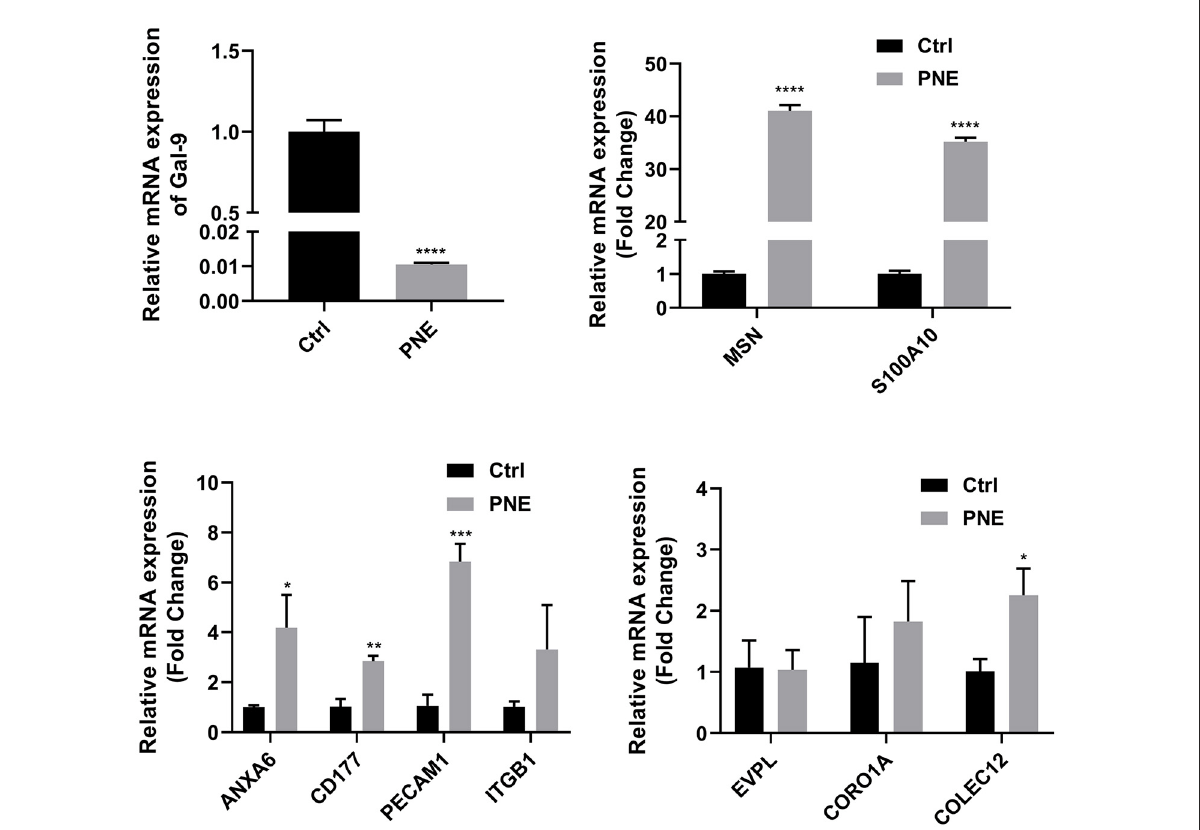
FIGURE7 Quantitative RT-PCR analyses of gene expression in normal and diseased tissues. Quantitative expression patterns of genes, which was calculated based on Ct value normalized against the housekeeping GAPDH gene. The *, **, and *** symbols indicate the P -value < 0.05, P -value < 0.01, and P -value < 0.001